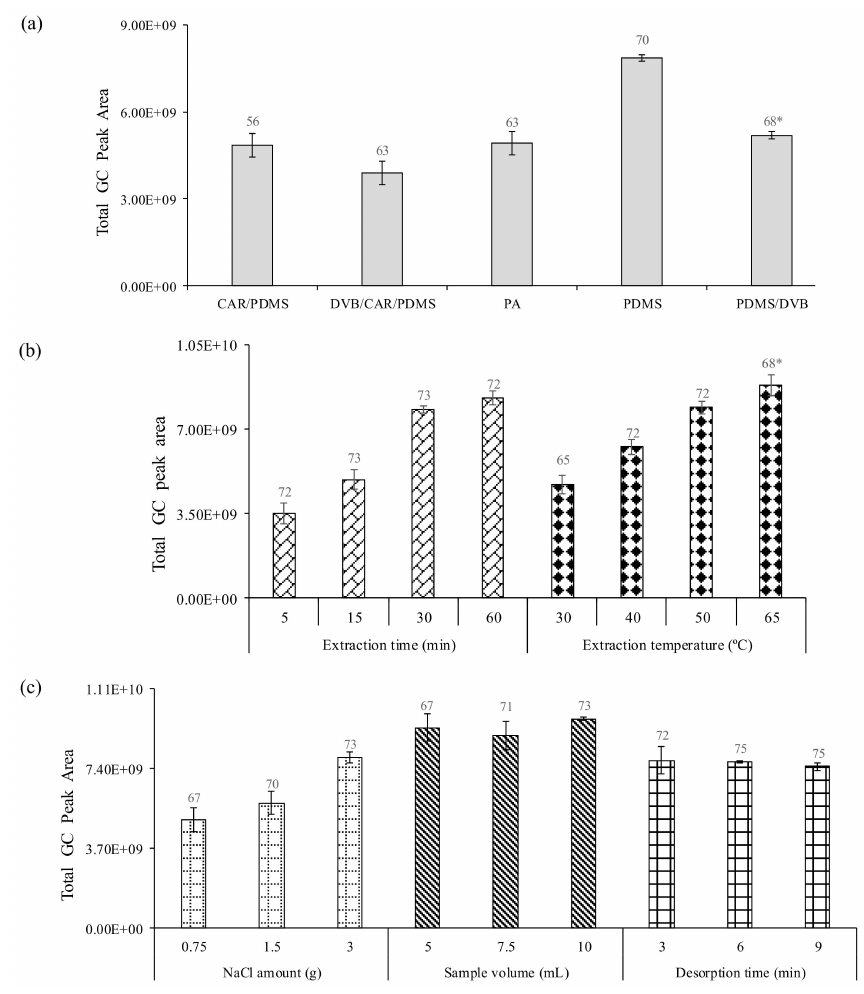
Figure 2. Effect of ( a ) fiber coating; ( b ) extraction time and extraction temperature; and ( c ) ionic strength, sample volume, desorption time on the volatile compounds extraction efficiency from wine vinegar. Error bars represent mean standard error ( n = 3 for each data point). * Number of identified